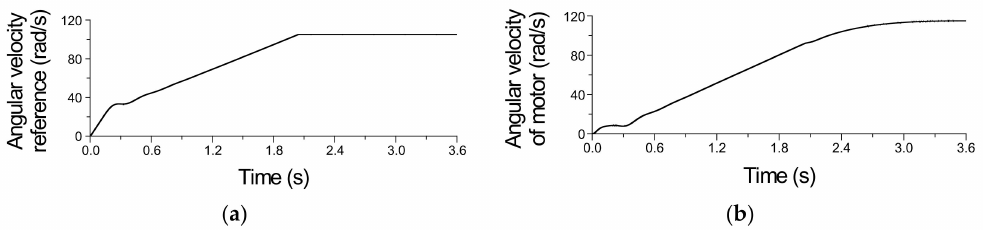
Figure 18. Waveforms of the angular velocity reference ( a ) and the angular velocity of the motor ( b ) during start-up in the system shown in Figure 7 for the 1 kg · m 2 moment of inertia of the total mass containing the rotor of the DC generator and the disc installed at the end of the